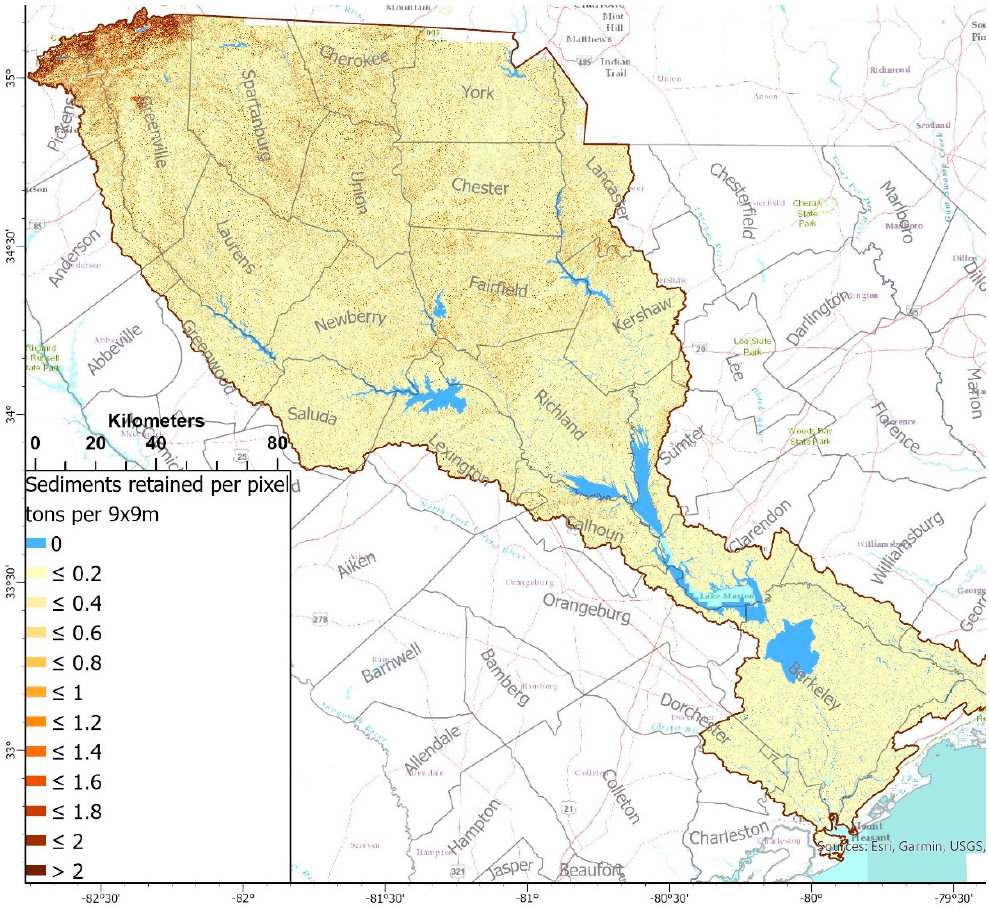
Figure 5. The results of the SDR model showed the geographic distribution of the areas with high and low capacity for sediment retention.